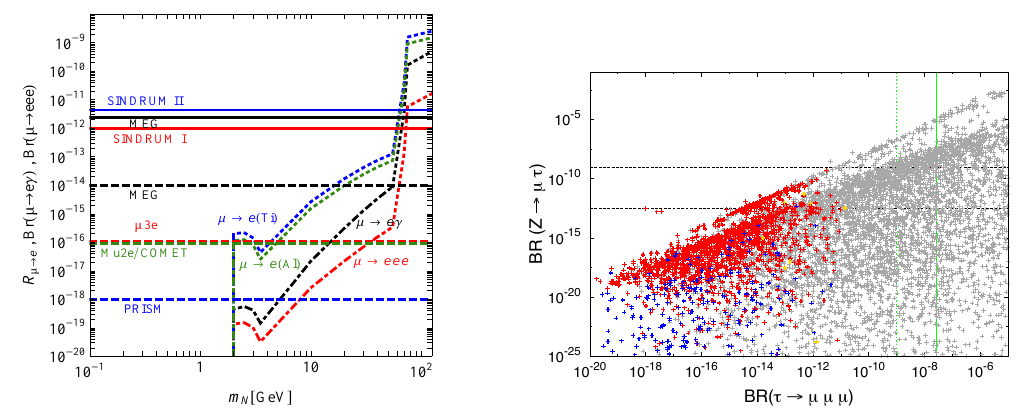
Figure 4: On the left, predictions obtained in a low-scale type I seesaw for the max- imal allowed cLFV rates compatible with current searches; horizontal full (dashed) lines denote present (future) experimental sensitivity. From [ 36 ] . On the right, a (3,3) ISS realisation: BR( Z → τµ ) vs. BR( τ → 3 µ ); vertical lines denote future experimental sensitivities while the horizontal ones correspond to the prospects of a GigaZ facility and of the FCC-ee; grey points are phenomenologically excluded. From [ 30 ]